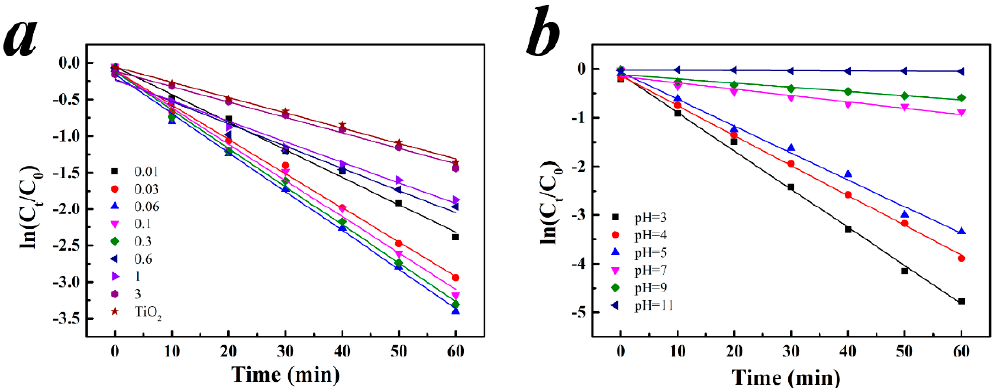
Figure 7. The study of kinetics at different Ag loadings ( a ) and pH values ( b ). Table 2. The relevant parameters obtained from kinetic study.